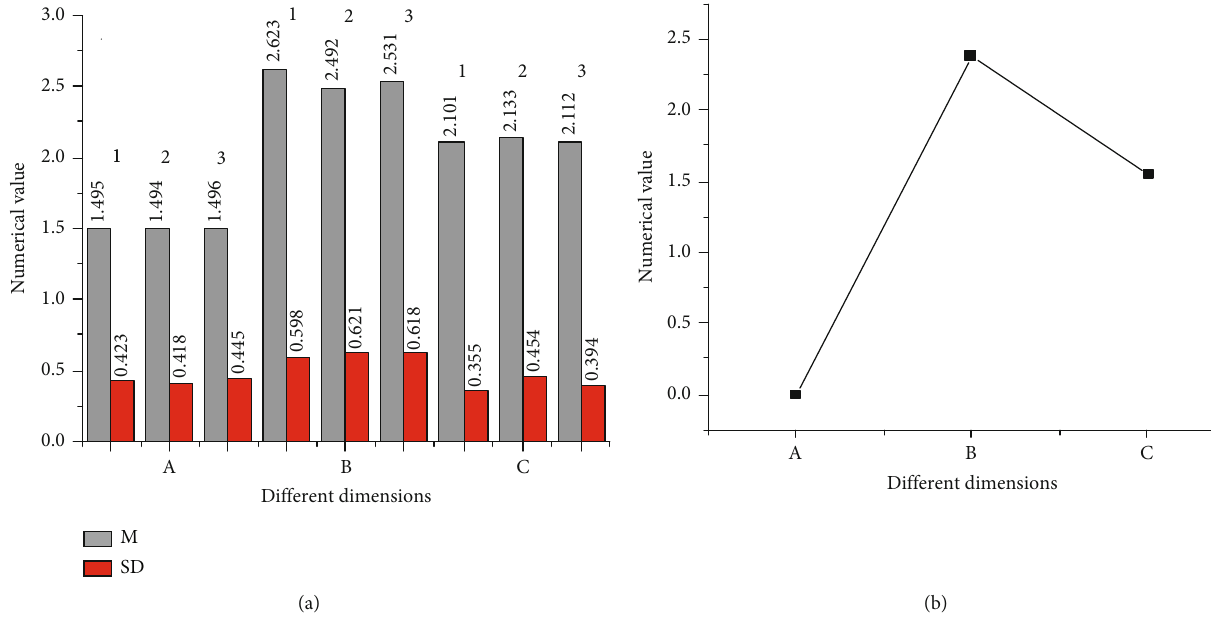
Figure 10: Comparison results of parenting styles of fathers with di ff erent education levels: (a) mean and standard deviation of the LSD test; (b) F value of the LSD test; A: father ’ s rejection; B: father ’ s emotional warmth; C: father ’ s overprotection; 1: above junior college; 2: high school/technical secondary school; 3: junior high school.